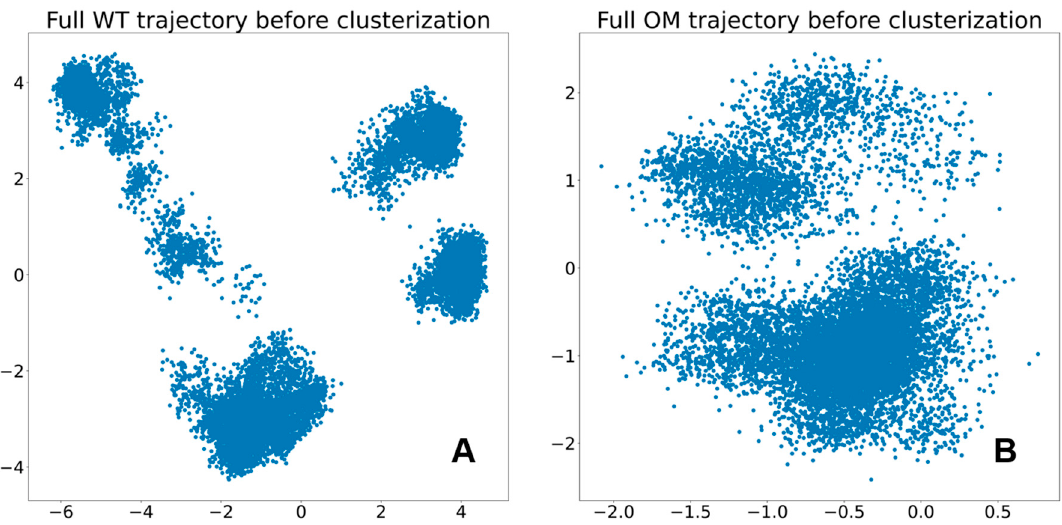
Figure 2. Distribution of the first two principal components of WT ( A ) and OM ( B ) RBM confor- mations in dPCA space.